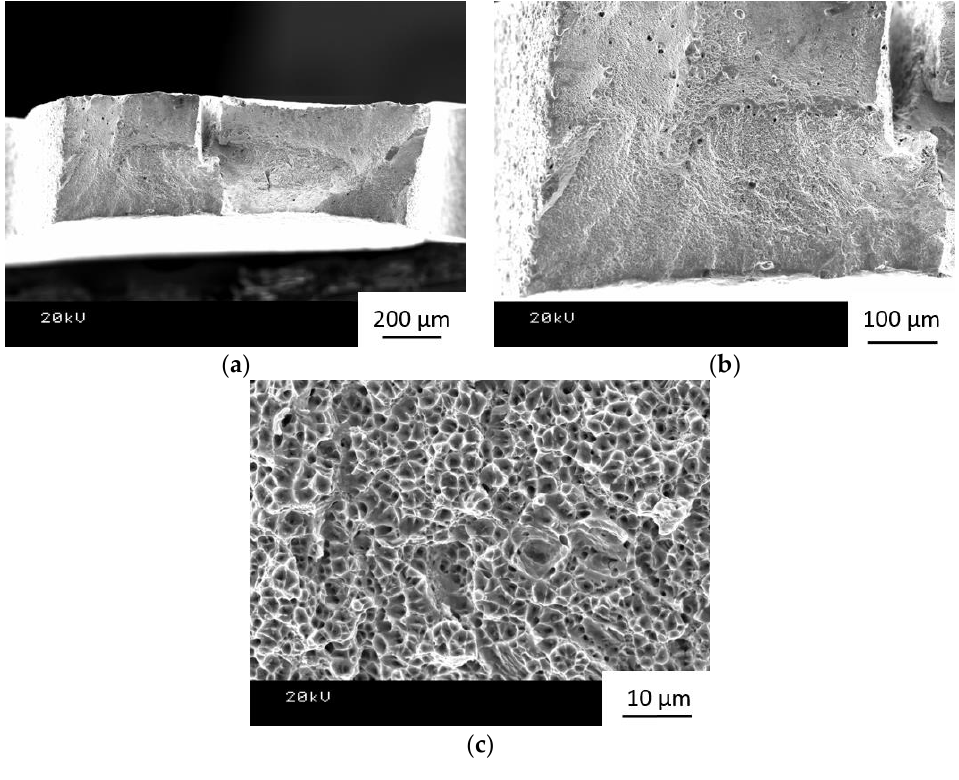
Figure 15. Fracture surface of 13_1 specimen: ( a ) View of the entire fracture surface; ( b ) Predominantly ductile fracture; and, ( c ) Ductile dimpled fracture region.